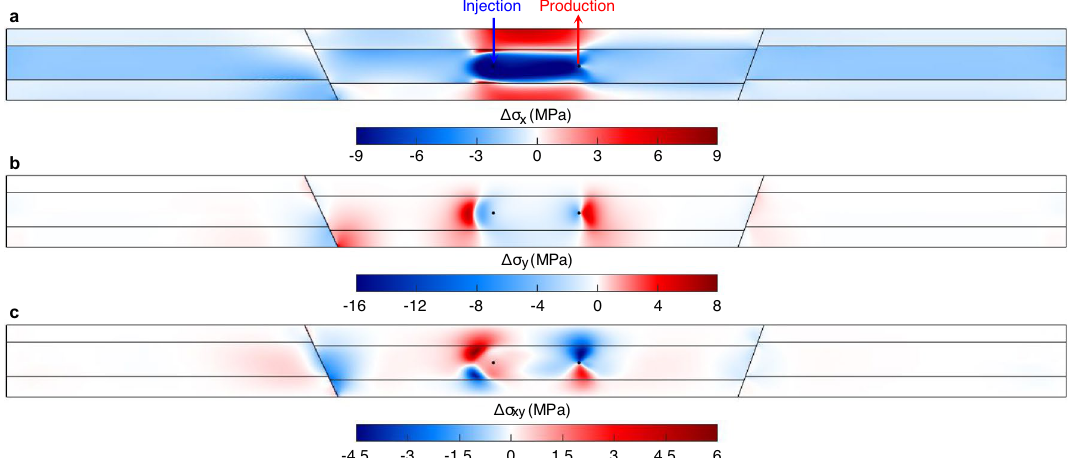
Figure 3. Stress distributions after 30 years of water circulation. Pore pressure changes and thermal effects redistribute the horizontal ( a ), vertical ( b ) and shear ( c ) stresses. Note that the fault slip that has already occurred also contributes to stress redistribution with large vertical stress drop induced along the